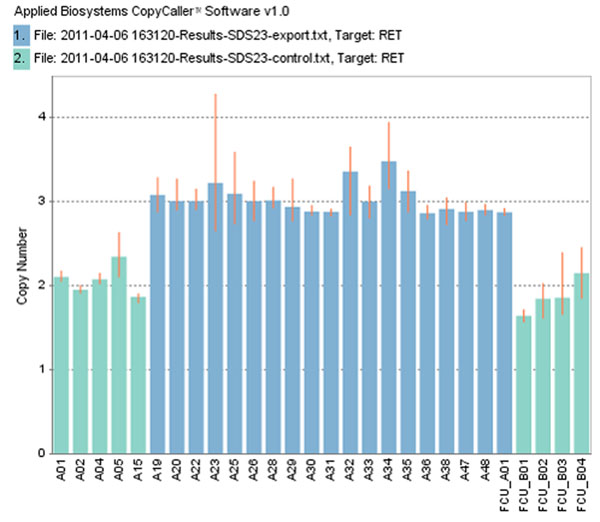
Real-time PCR result of the CNV region on 10q11.21 in RET. The CN state of case samples (n = 19, blue bar) are higher than the CN state of control samples (n = 9, green bar).